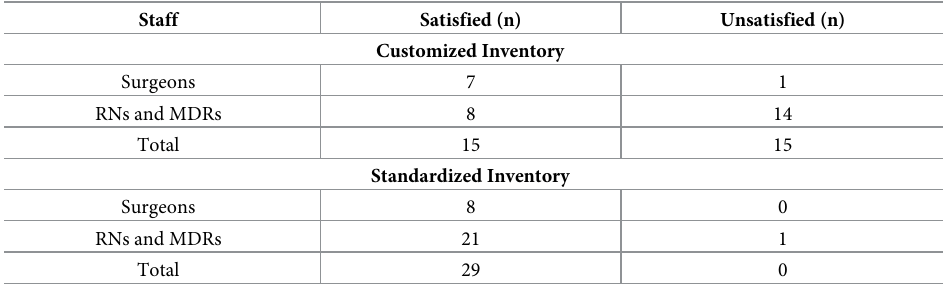
Table 4. Satisfaction survey results of customized trays vs standardized